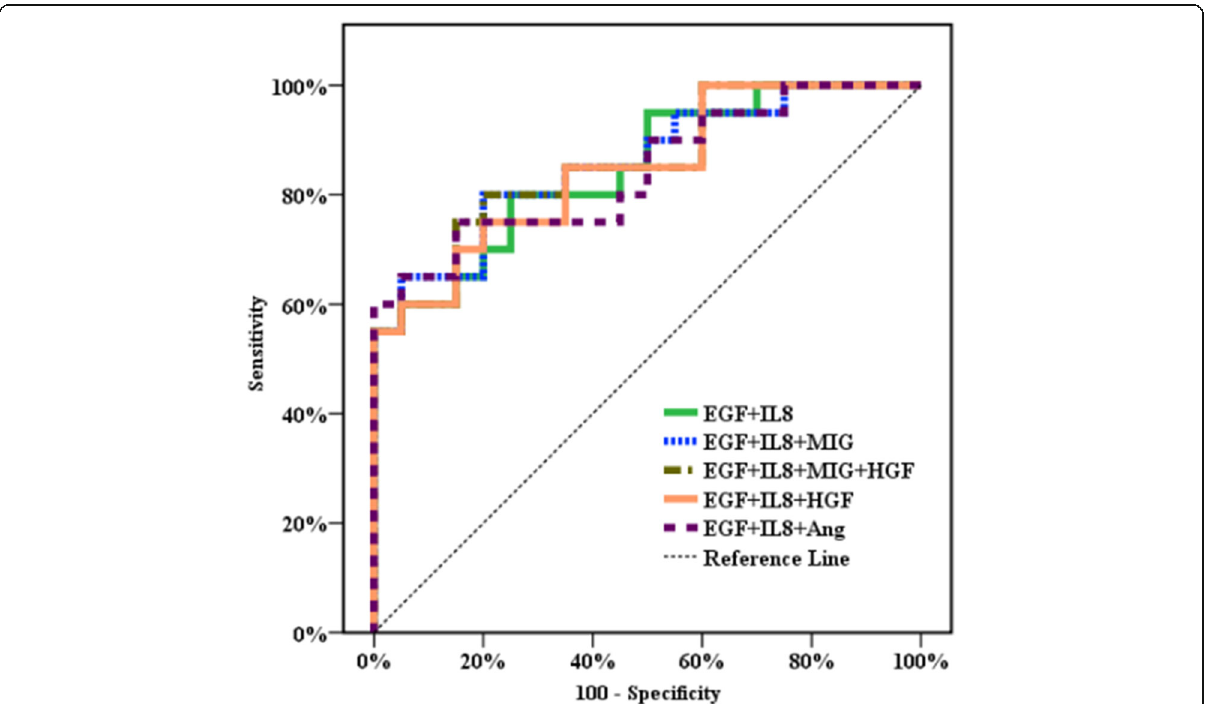
Fig. 1 Receiver operating characteristics (ROC) curves for different marker combinations to discriminate malignant from benign nodules. IL